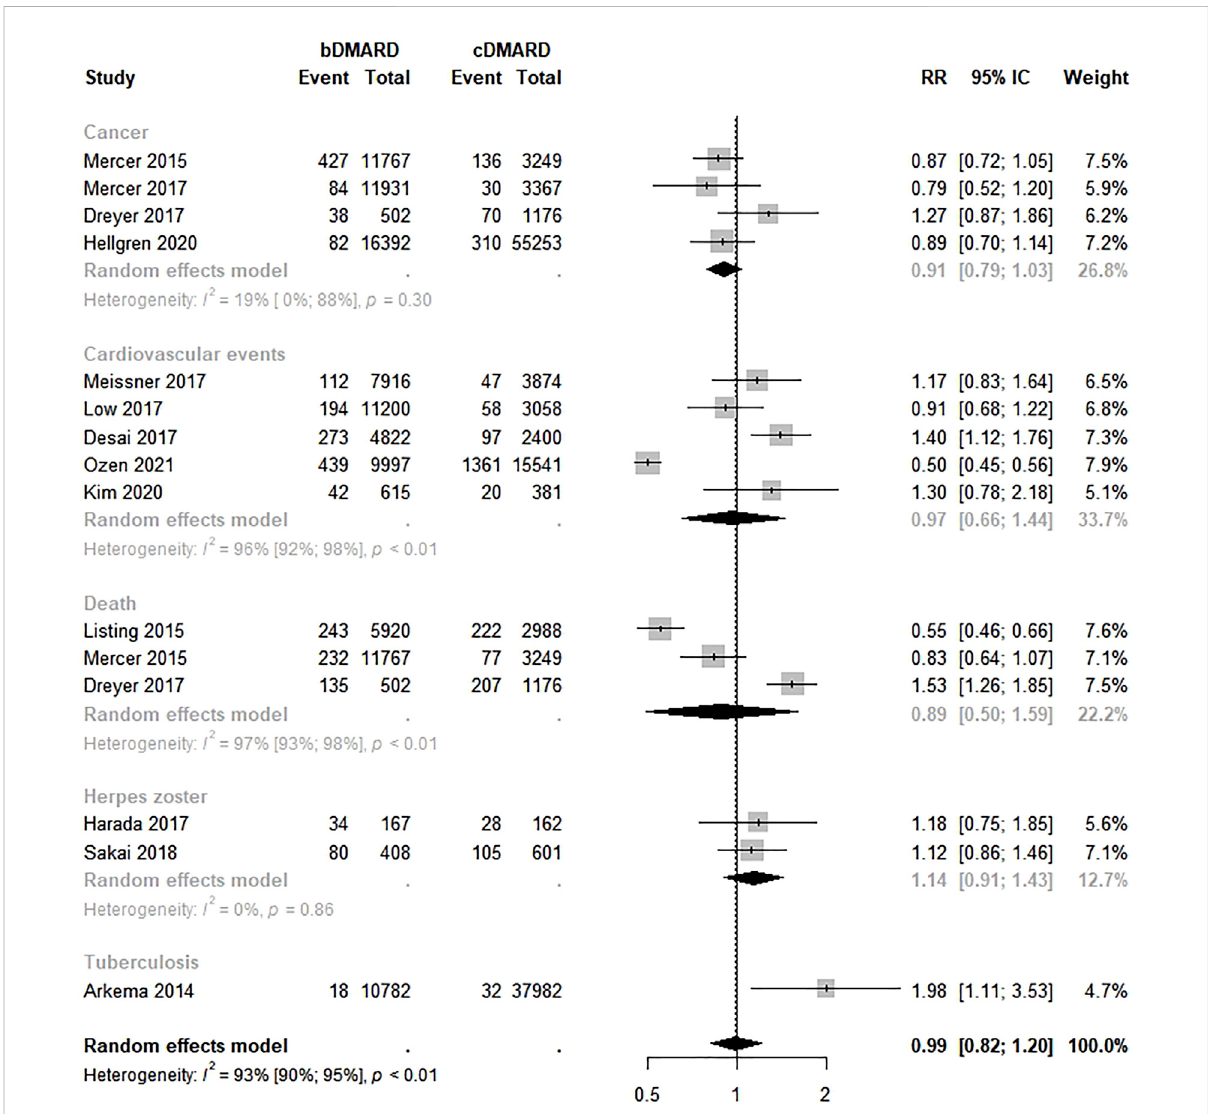
FIGURE 4 Comparative safety of biological disease-modifying anti-rheumatic drugs and conventional disease-modifying anti-rheumatic drugs. bDMARD: biological disease-modifying anti-rheumatic drugs; cDMARD: conventional disease-modifying anti-rheumatic drugs.